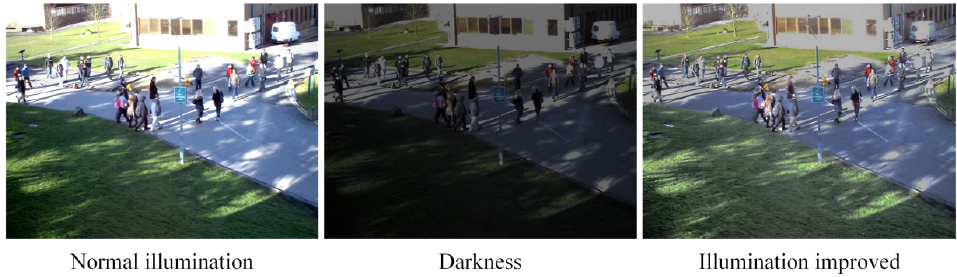
Figure 10. The examples of the normal illumination, darkness, and the illumination-improved im- age.